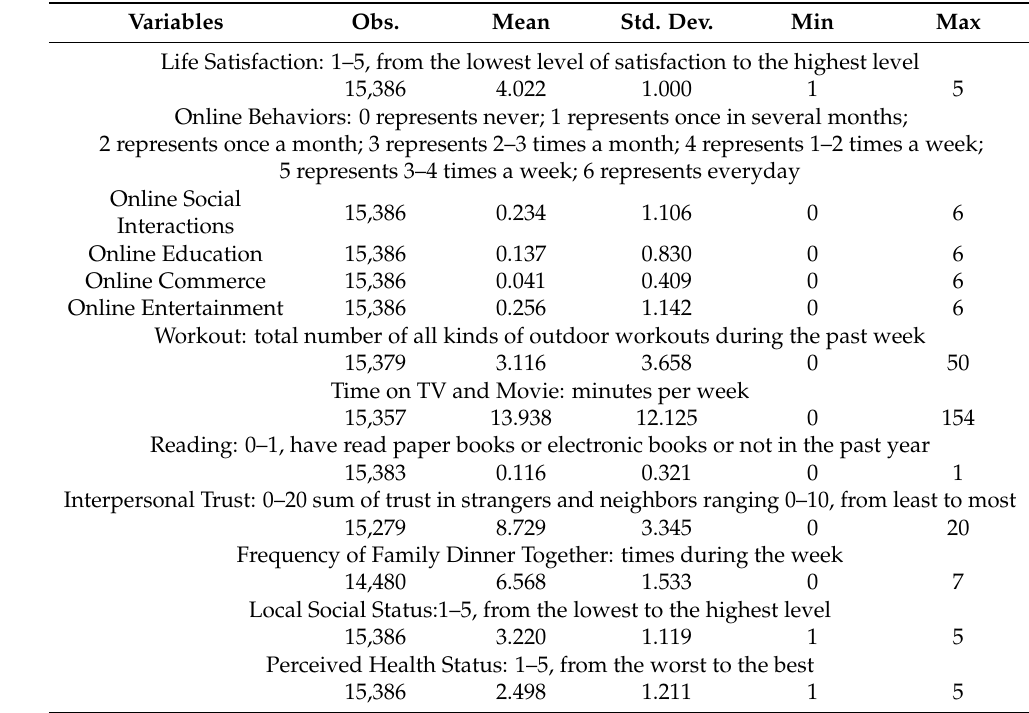
Table 1. Statistics description of regression sample. Variables Obs. Mean Std. Dev.